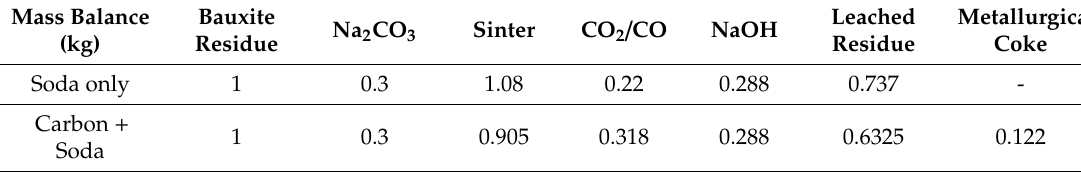
Figure 22. Total proposed flowsheet for the recovery of aluminum and sodium. Table 3. Mass balance of input and output from sintering system (Soda only vs Carbon +